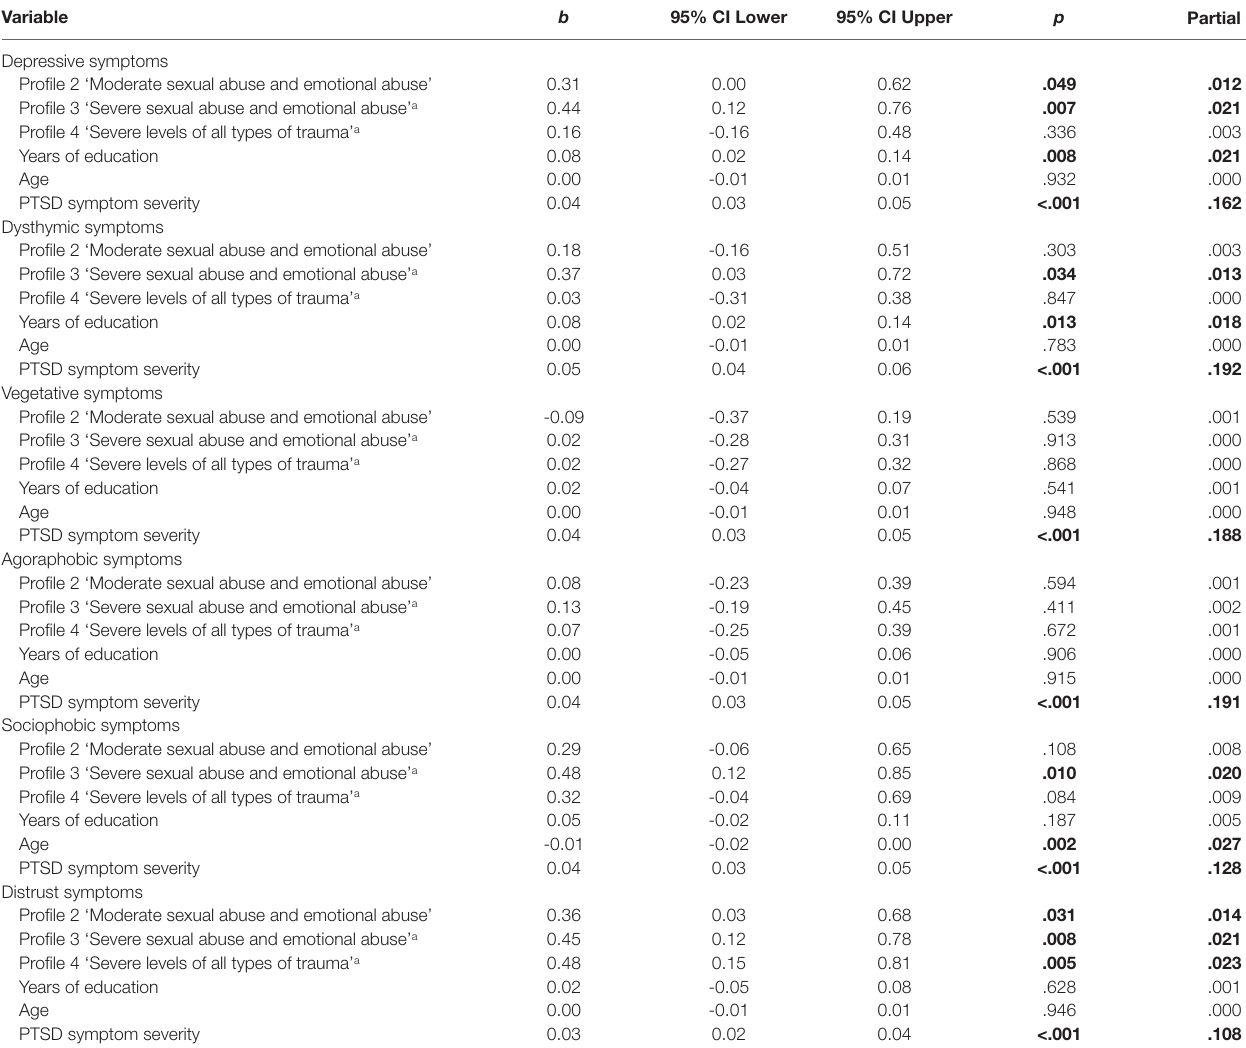
TABLE 4 | Effects of childhood trauma profiles on current clinical symptom severity (N = 343). Variable